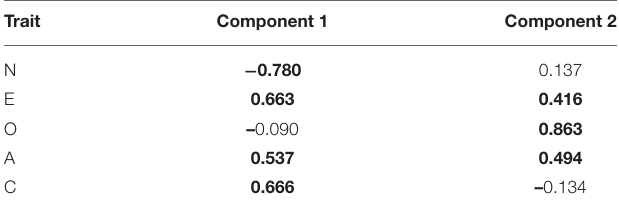
TABLE 5 | Component-analysis of the first two quartimax components extracted from analysis of the NEO-FFI traits ( n = 378).